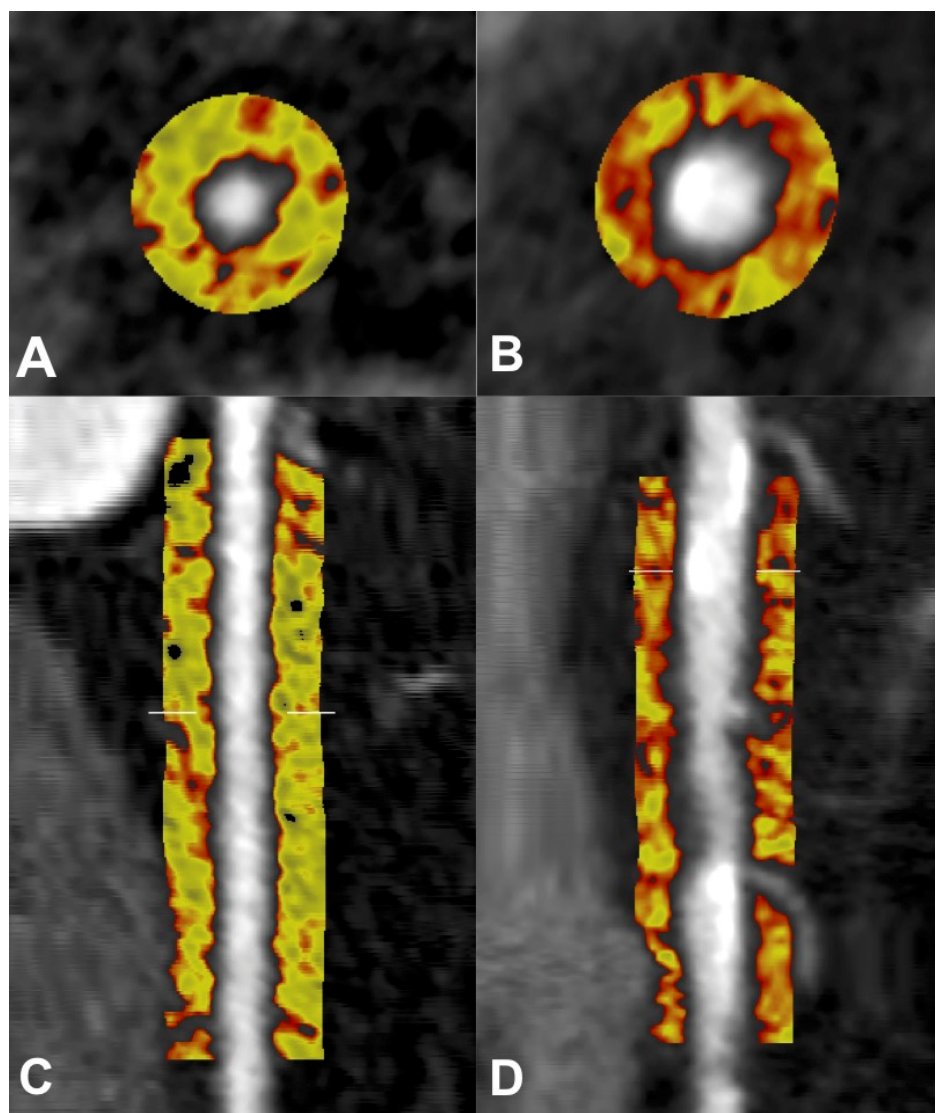
Figure 3. Pericoronary adipose tissue (PCAT) shown in cross-sectional ( A , B ) and longitudinal ( C , D ) views of the right coronary artery (RCA) on coronary computed tomography angiography (CTA). PCAT in RCA without plaque represented in the left panels ( A , C ), and PCAT in RCA with calcified and non-calcified plaque represented in the right panels ( B , D ). Colour map describes spectrum of adipose tissue attenuation values in Hounsfield units (HU), ranging from − 190 HU (yellow) to − 30 HU (red), with higher attenuation values indicating inflammatory changes.